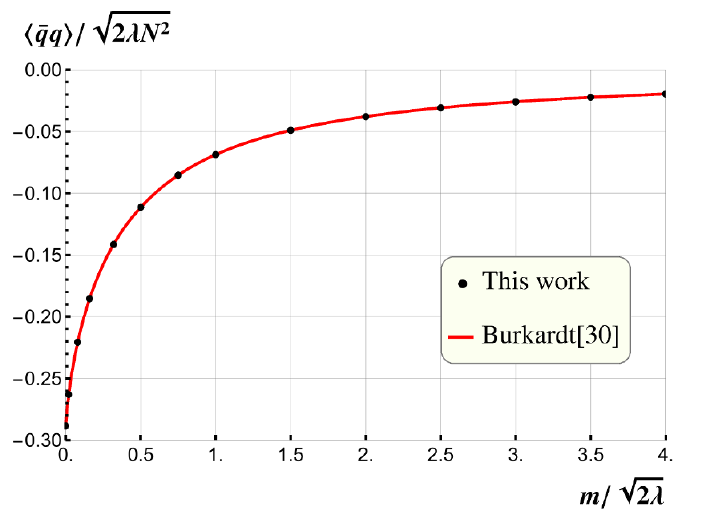
Figure 5 . Renormalized quark condensate as a function of quark